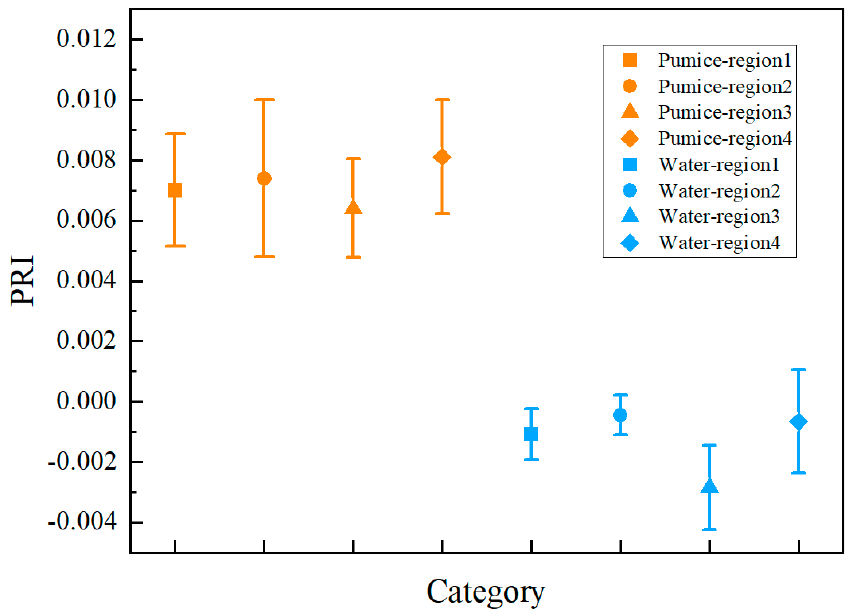
Figure 4. Mean and standard deviation of PRI from pumice and water pixels in selected regions (marked in Figure 1a,b). Areas > 300 pumice pixels were selected at each region for statistics. Scattered noise from wave-induced glint affected the automatic extraction of